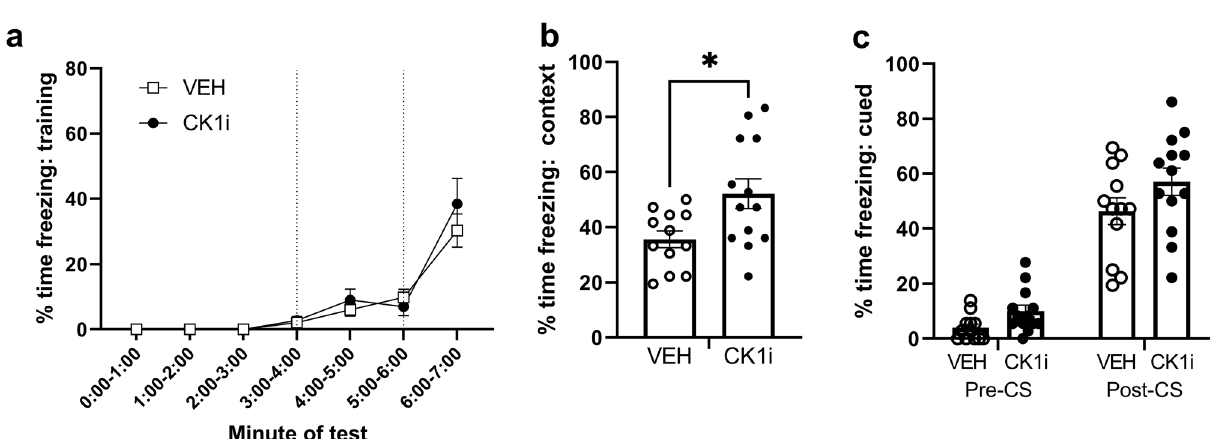
Figure 3. Mice treated with 10 mg/kg PF-670462 display increased freezing behavior in contextual fear conditioning, but have normal training behavior and performance on the cued test. ( a ) Freezing behavior over time during training. Dotted lines indicate presentation of tone-shock pairing. (VEH: n = 12 mice, CK1i: n = 13 mice). ( b ) Freezing behavior in the contextual test (VEH: n = 12 mice, CK1i: n = 13 mice). ( c ) Freezing behavior in the cued test (VEH: n = 12 mice, CK1i: n = 13 mice). Each dot represents a mouse. Data are represented as mean ± SEM. *p < 0.05, Student’s t-test with Welch’s